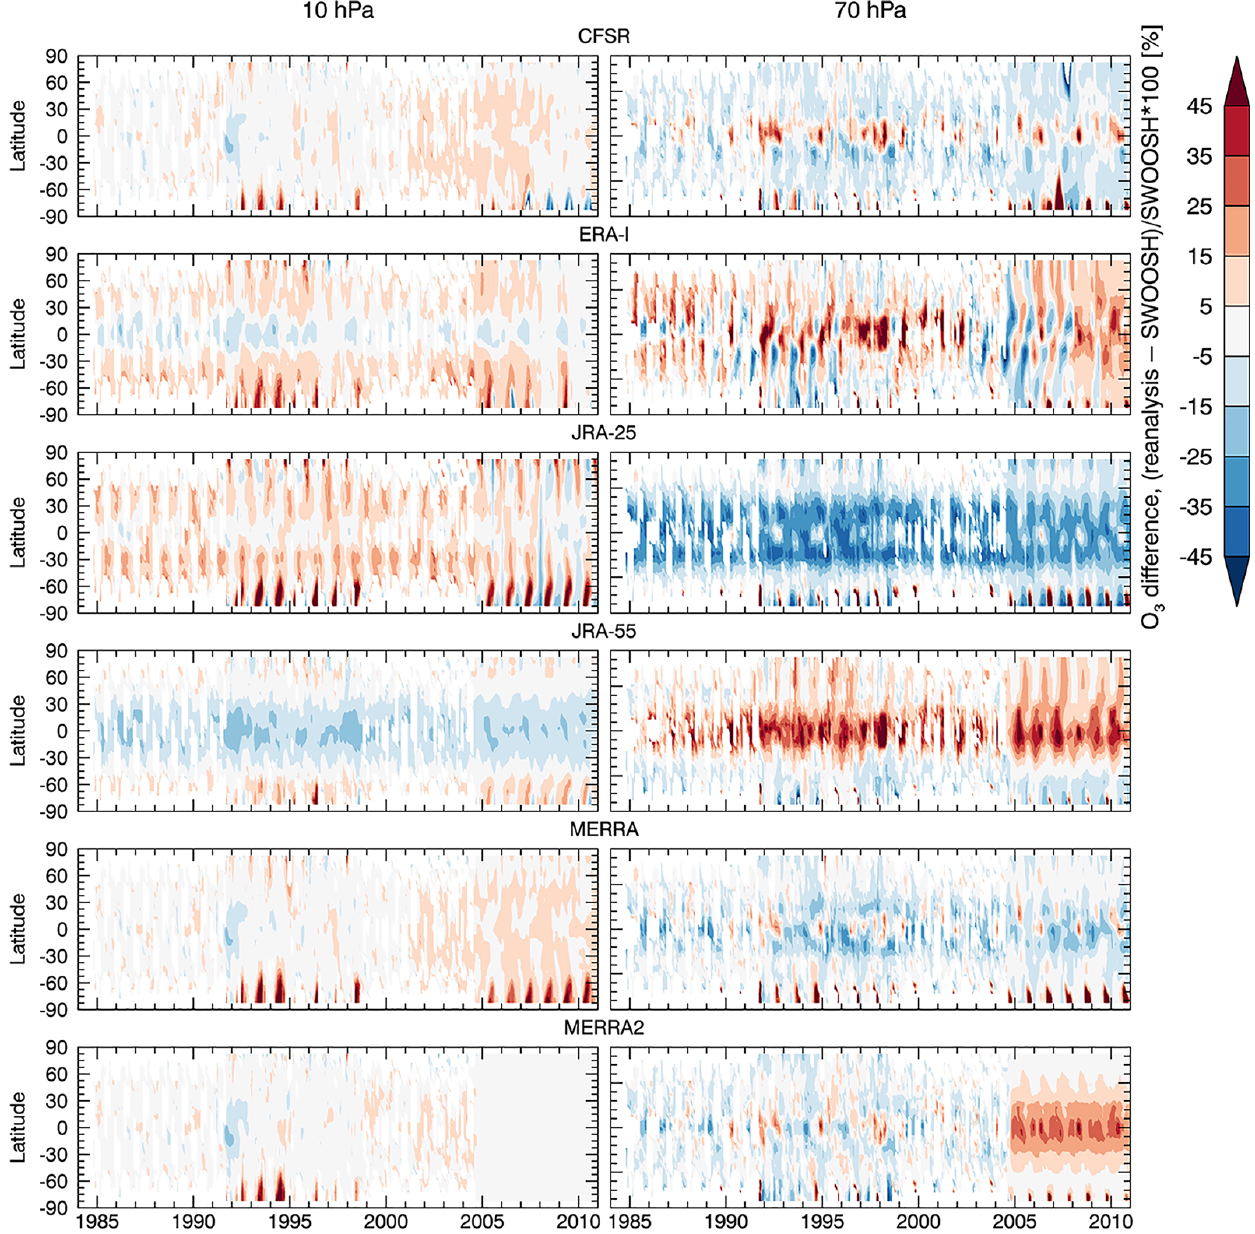
Figure 11. Latitude–time evolution of relative differences between ozone reanalyses and the merged SWOOSH ozone record at 10 and 70hPa. White indicates missing data, and light grey indicates near-zero differences (e.g., between MERRA2 and SWOOSH after